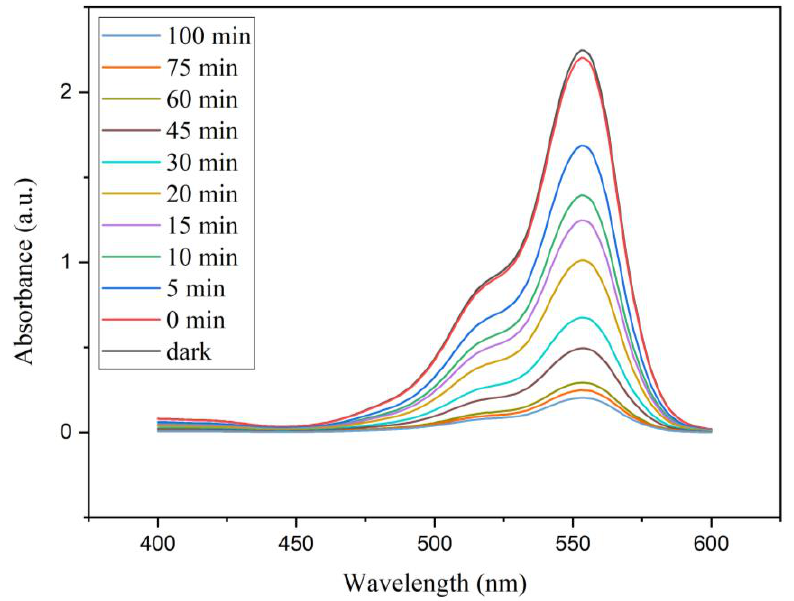
Figure 8. Time-dependent UV-visible absorption spectra of the RhB solution in the presence of AgNW/TiO 2 /GO nanocomposite samples.